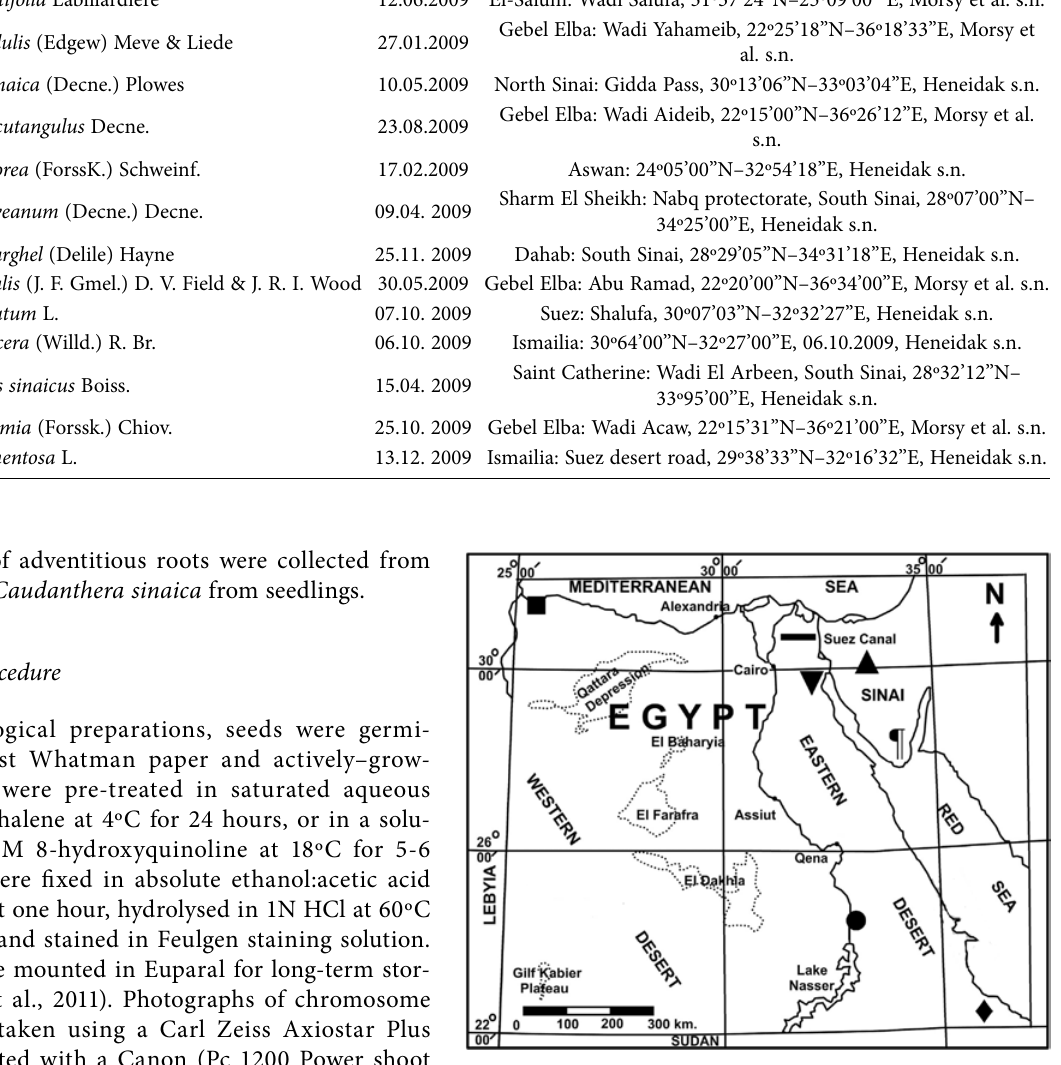
Figure 1. The distribution map of the studied species in Egypt. Periploca angustifolia (■); Caudanthera edulis , Desmidorchis acu- tangulus , Pentatropis nivalis , Pergularia daemia ( ♦ ); Caudanthera sinaica ( ▲ ); Leptadenia arborea ( ● ); Glossonema boveanum , Sole- nostemma arghel , Gomphocarpus sinaicus (¶); Cynanchum acutum ( ▼ ); Calotropis procera , Pergularia tomentosa ( ▬